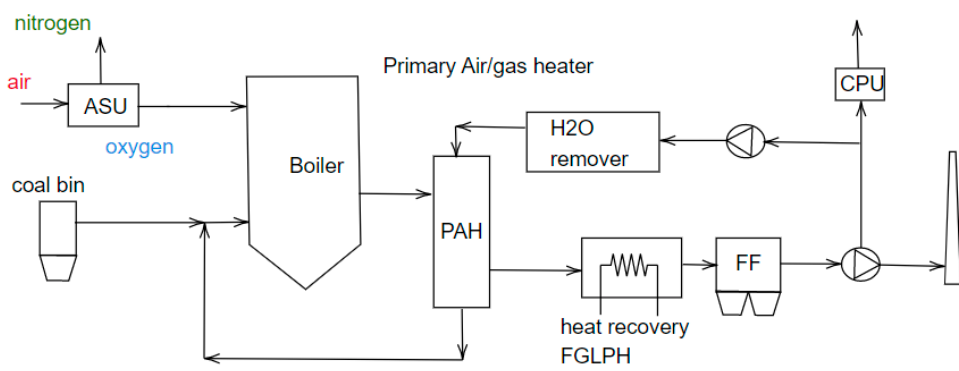
Figure 5. The Callide oxyfuel pilot process [111].